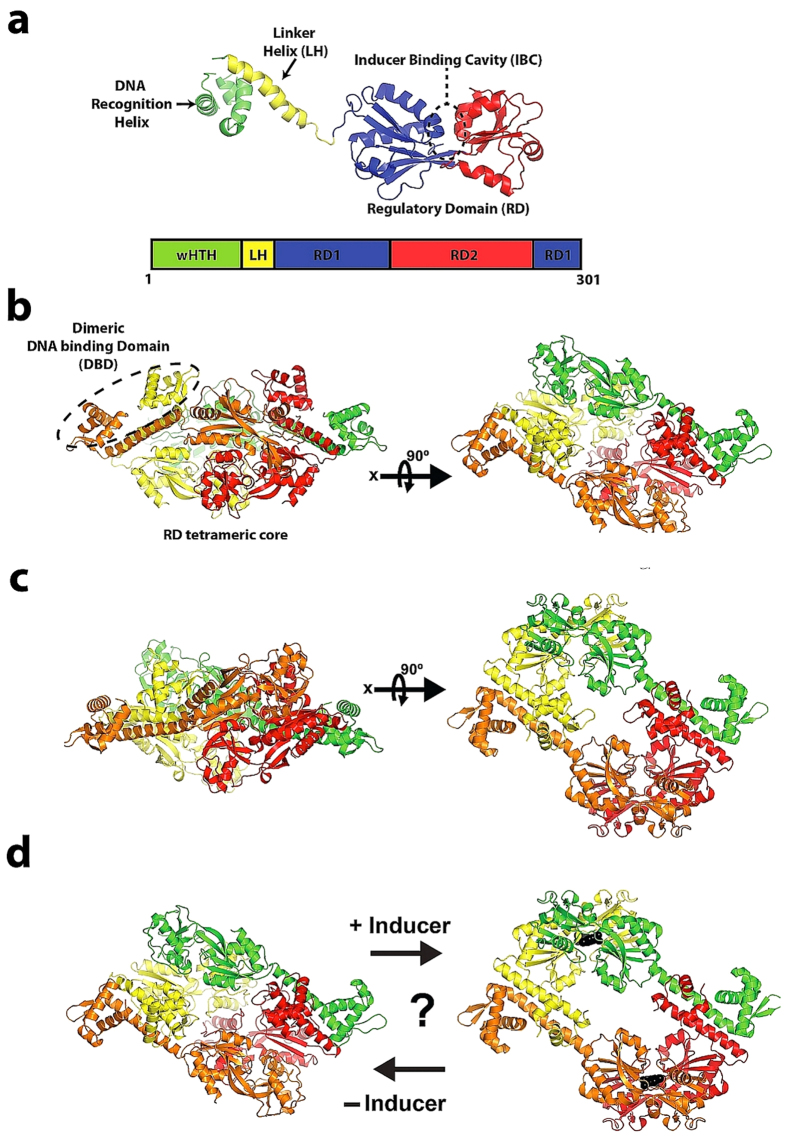
Orthogonal views of the compact and extended tetrameric configurations seen
in the crystal structures of full length LTTRs.(a) The domain structure of LTTR monomers. Major elements are
labelled. (b) The crystal structure of CbnR14 showing
LTTR homotetramers (each monomer coloured differently) in a compact
configuration. The position of one of the wHTH dimers that flank the central
tetrameric RD core is highlighted. (c) The crystal structure of
TsaR7 showing LTTR homotetramers in an extended
configuration. (d) The current hypothesis is that activation of LTTRs
leads to a change in conformation from compact to expanded homotetrameric
configurations.